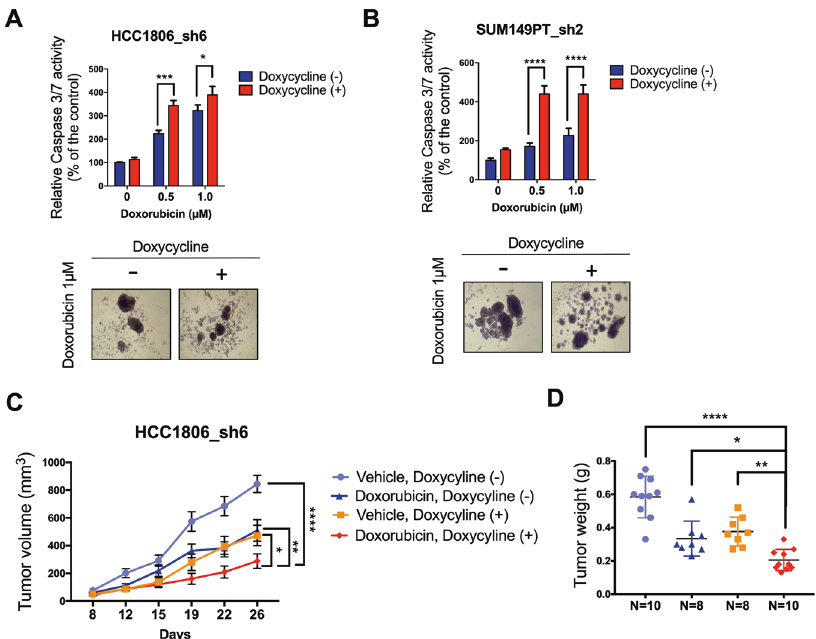
Fig. 3 MLK4 promotes chemoresistance in 3D cell culture and in vivo models. A – B MLK4 knock-down was induced by doxycycline in HCC1806_sh6 and SUM149PT_sh2 cells grown in non-adherent conditions and subsequently cells were treated with doxorubicin at indicated concentrations for 48 h. The activity of caspases 3/7 was measured using bioluminescence assay. Representative pictures of mammospheres upon doxorubicin treatment are shown. Error bars indicate ±SEM from three independent experiments, performed in triplicates ( n = 9). Signi fi cance was calculated using an unpaired two-tailed t -test, * p < 0.05, ** p < 0.01, **** p < 0.0001. C HCC1806_sh6 cells were injected into mammary fat pads of RAG2 − / − mice. Doxycycline was administered one day after the injection to induce MLK4 knock-down. Mice were treated with doxorubicin (4 mg/kg, i.p.) or saline at 5-day intervals, starting from day 7 of the experiment. Tumors were measured twice a week. Error bars indicate ±SEM ( n = 10 for control group, n = 8 for doxorubicin-treated group, n = 8 for doxycycline-treated group, n = 10 for combination treatment group). Statistical comparison was performed using two-way ANOVA, * p < 0.05, ** p < 0.01, **** p < 0.0001. D Weight of tumors resected at the end of the study. Signi fi cance was calculated using one-way ANOVA followed by Tukey multiple comparisons